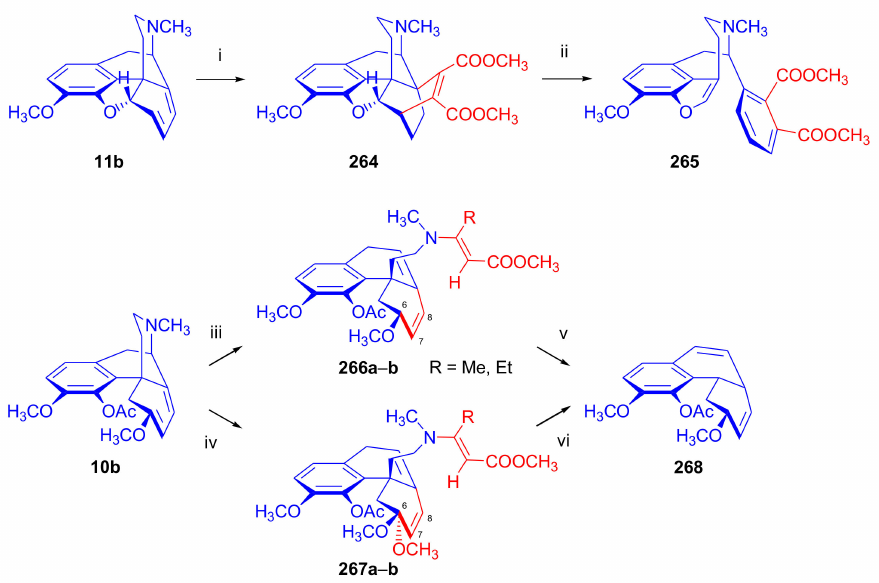
Figure 72. Reactions of 6-demethoxythebaine and 4- O -acetyl- β -dihydrothebaine with dimethyl acetylendicarboxylate and propargylic acid ethyl ester. Reagents and conditions : (i): MP or DMAD, benzene, reflux, 12 h, 72%; (ii): xylene, reflux, 10 min; (iii): MP or DMAD acetonitrile, room tempera- ture, 30 min, or benzene, room temperature, 3h; (iv): MP or DMAD, methanol, room temperature, 5–10 min; (v): chloroform, 50 ◦ C, 5 min; and (vi): thermal decomposition at 70 ◦ C.